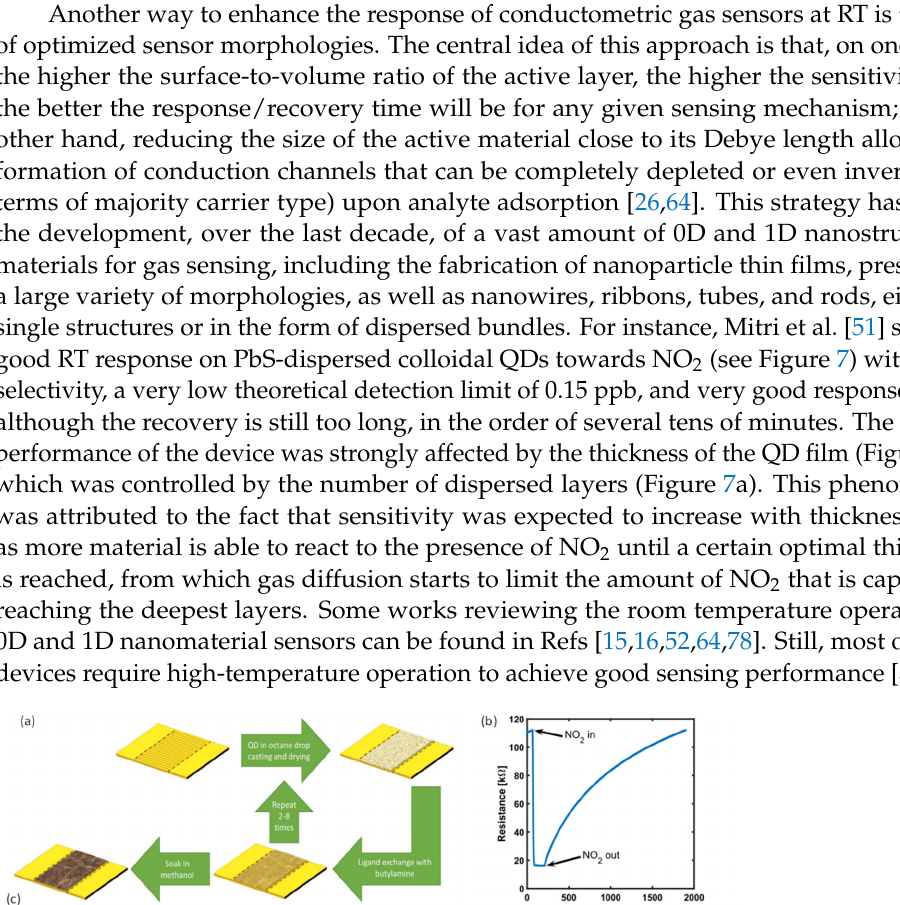
Figure 6. Opposing sensing mechanisms of NiO towards ethanol analyte at room temperature. ( a ) Direct charge transfer induces a resistance decrease in the sample with fast recoveries after remov-